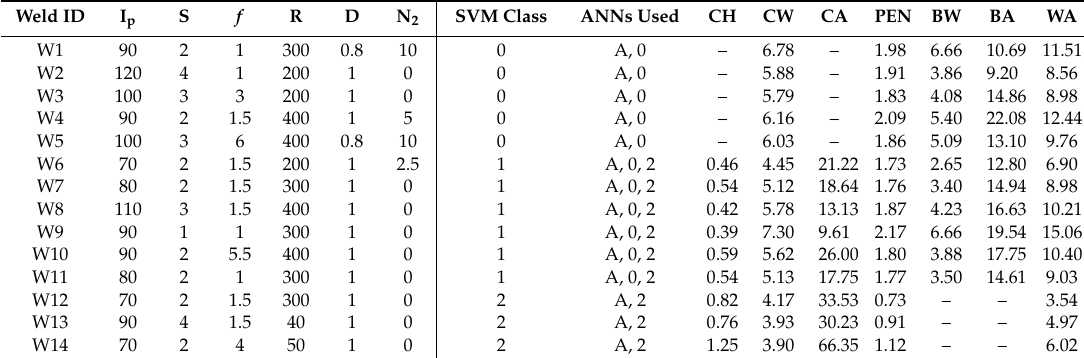
Table 5. Bead geometry predictions using the hybrid SVM–ANN algorithm.